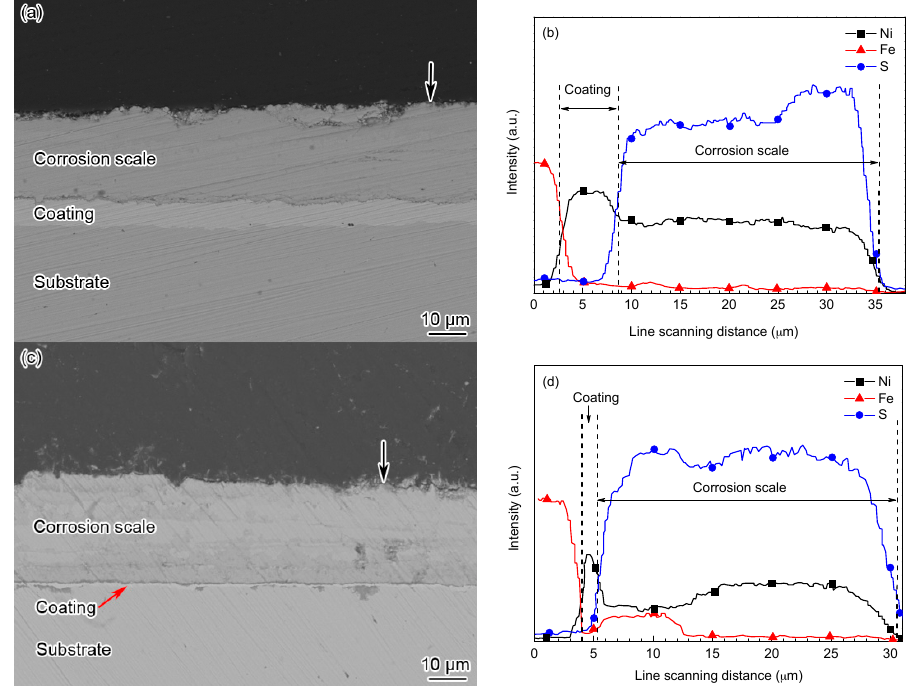
Figure 10. ( a , c ) SEM cross-sectional backscattered electron images and ( b , d ) elemental distributions in cross-sections of the Ni-based alloy coating and corrosion scale exposed to the H 2 S/CO 2 environment at 140 °C: ( a ) after being corroded for 168 h; ( b ) denoted by the black arrow in ( a ); ( c ) after being corroded for 360 h and ( d ) denoted by the black arrow in ( c ).